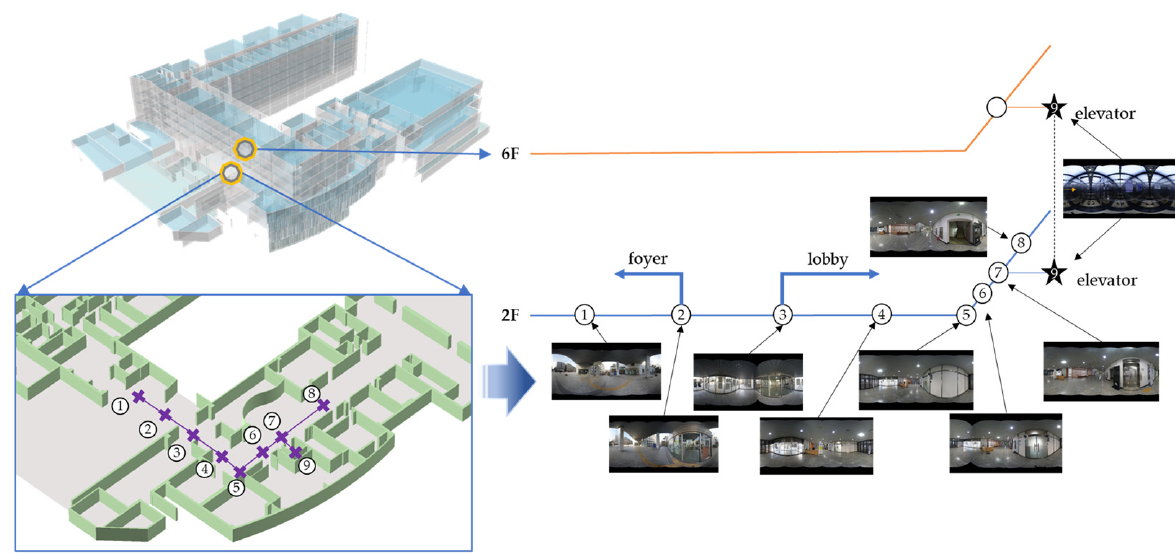
Figure 13. Shooting points and the captured images for a portion of the study area.